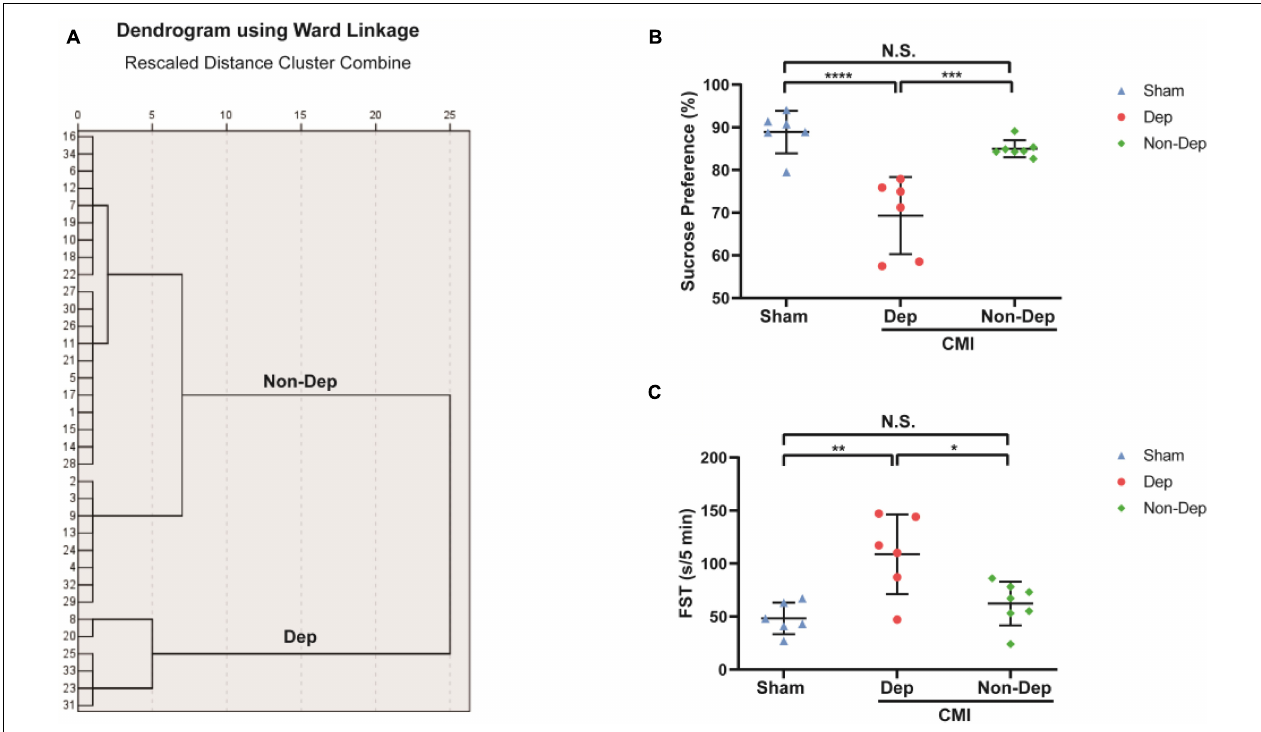
FIGURE 3 | Comparisons of SPT and FST among Sham group, CMI + Dep group, and CMI + Non-Dep group rats. (A) Dendrogram of hierarchical clustering analysis. A total of 34 CMI rats were included, and 6 CMI rats were divided into depression-like behavior groups by SPT results of hierarchical clustering analysis. (B) SPT. (C) FST. Data are shown as mean ± SEM. ( n = 6–7) by one-way ANOVA. * p < 0.05, ** p < 0.01, *** p < 0.001, or **** p < 0.0001; N.S., not significant. CMI, chronic myocardial infarction; SPT, sucrose preference test; FST, forced swimming test; Dep, depression-like behavior; Non-Dep, non-depression-like